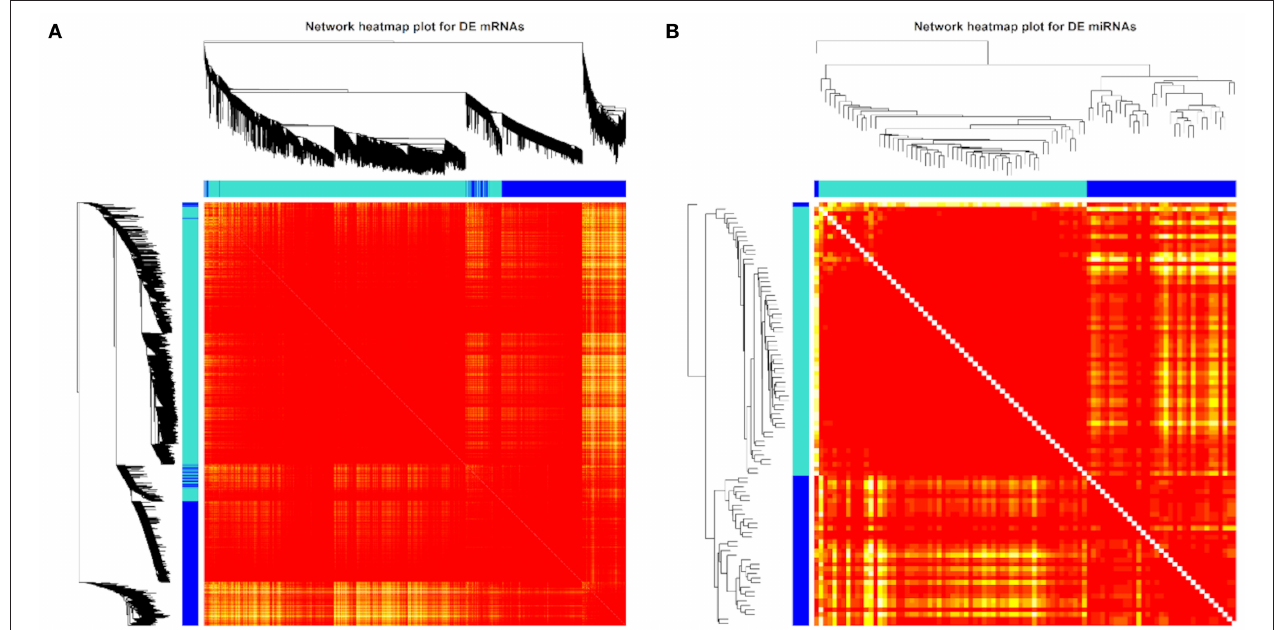
FIGURE 6 | Weighted differentially expressed (DE) (A) mRNA ( n = 3,856) and (B) miRNA ( n = 93) network heatmap of the co-expression interactions based on the topological overlap matrix (TOM) dissimilarity. The gene dendrogram and module assignment are shown along the left side and the top, where the axe colors indicate the different modules. The color intensity inside the heatmap represents the overlap degree, where a light color represents low overlap and a darker red color represents higher overlap. DE mRNA and miRNA results were achieved from our previous study ( 31, 32).